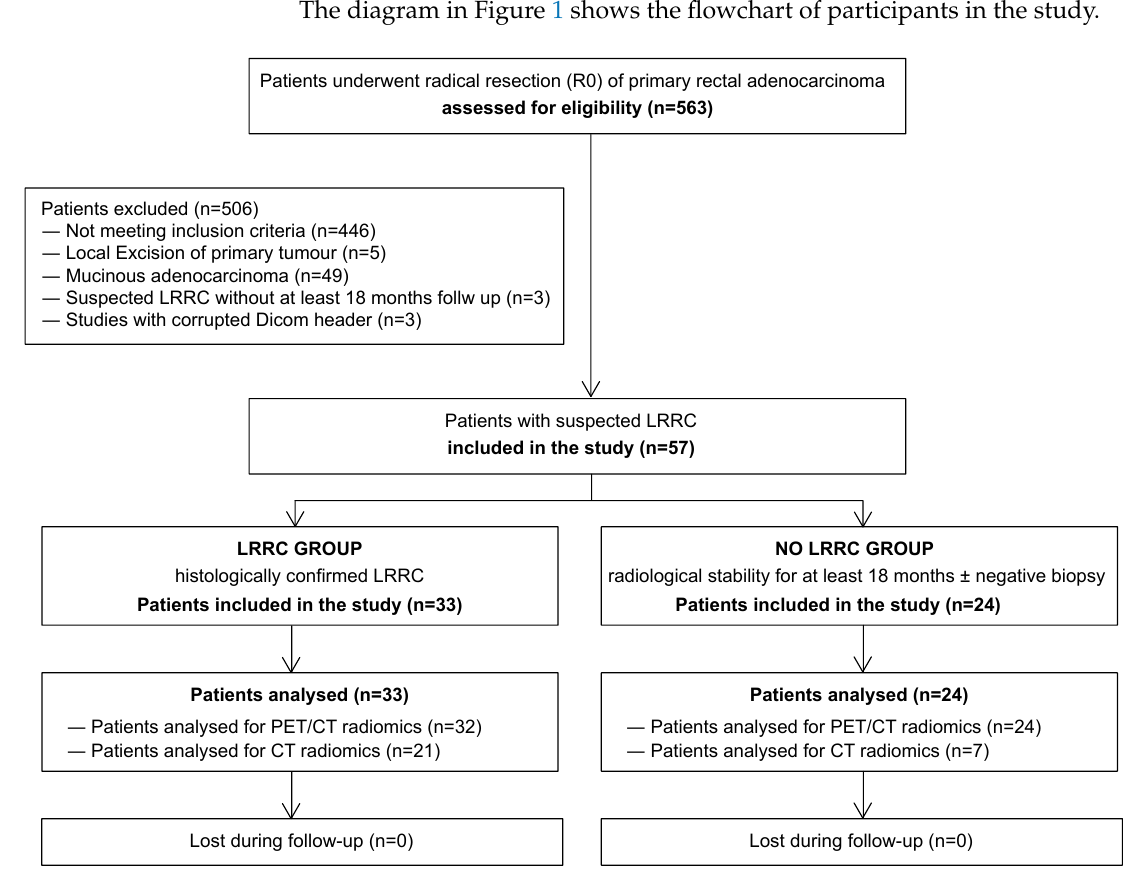
Figure 1. Flowchart of patients’